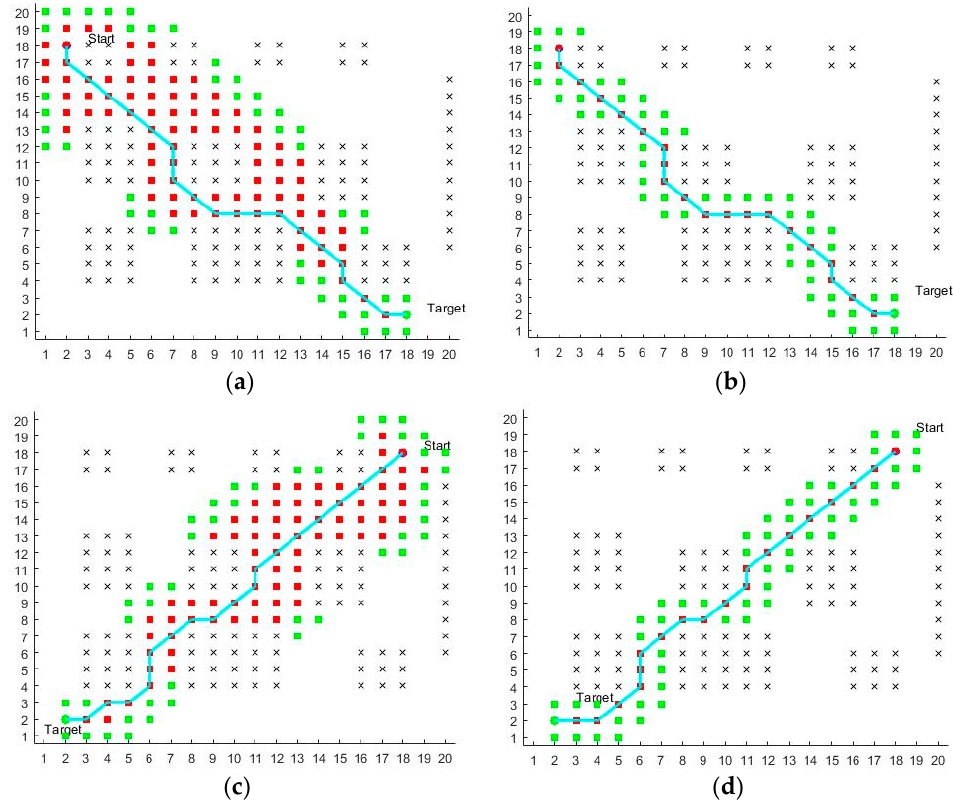
Figure 9. Global path comparison for map replacement. ( a , c ) Traditional A-star algorithm; ( b , d ) optimization of the A-star algorithm.